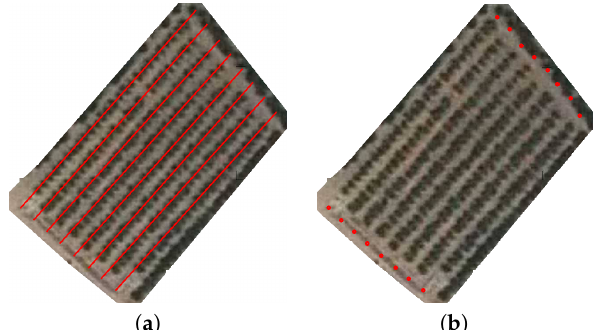
Figure 7. Detecting tree rows with Hough: ( a ) the extended satellite image related to the parcel with the detected lines and ( b ) the extended parcel with detected